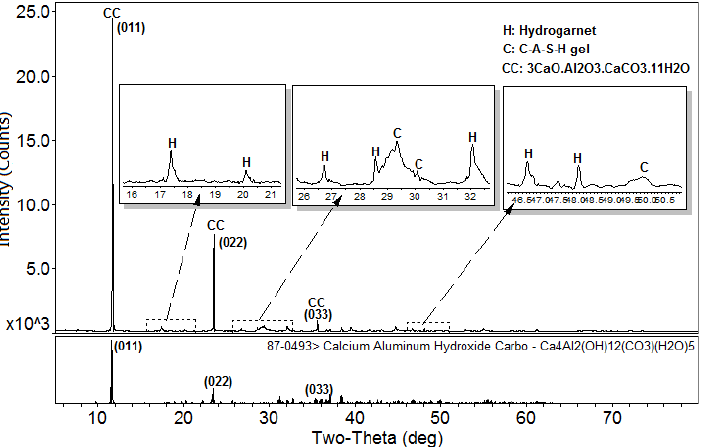
Figure 2. XRD patterns of the C-A-S-H2.0_60_7d powders. (C: C-A-S-H gels; K: Katoite; CC: C 4 AcH 11 ).